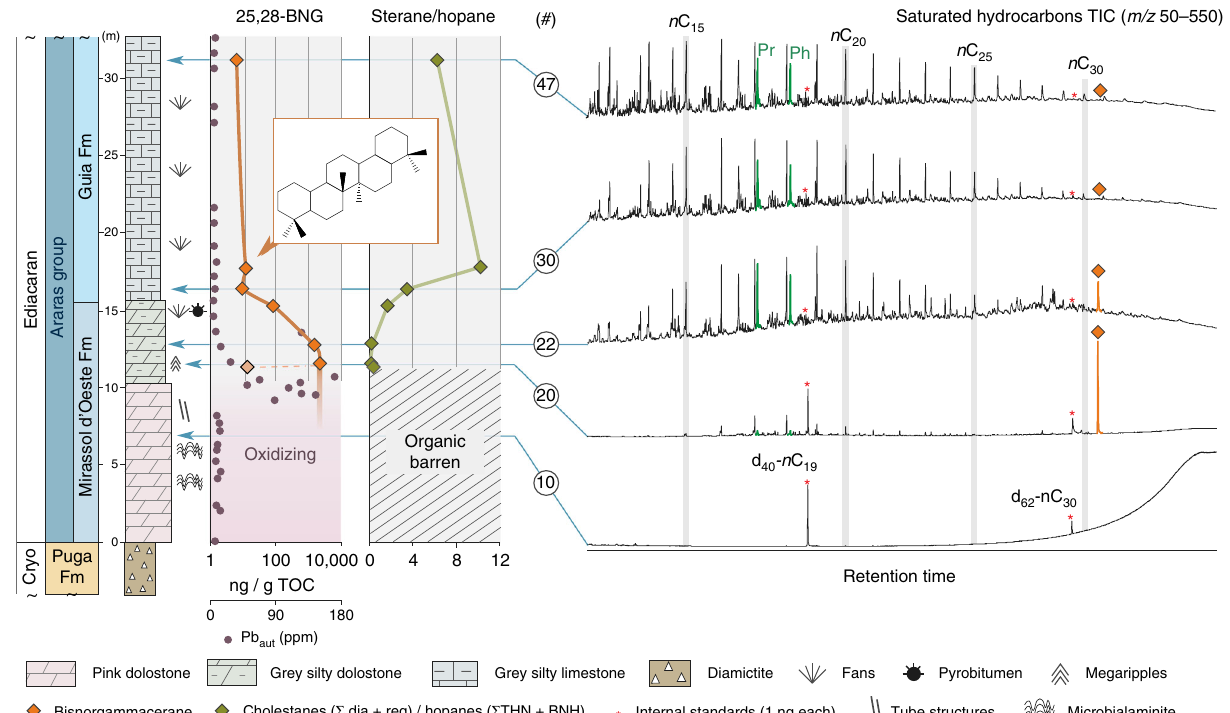
Fig. 1 25,28-bisnorgammacerane in the Araras cap dolostone. The lower Araras cap dolostones contain no preserved hydrocarbons (chromatogram #10), in agreement with an oxidising depositional environment. Following the precipitation and drawdown of redox-sensitive lead (Pb authigenic ) upon decreasing Eh, and allowing for organic preservation (around 11 m), the fi rst observed dominant hydrocarbon biomarker (>1000 ng/g TOC, #20) after the Marinoan Snowball Earth has been identi fi ed as 25,28-bisnorgammacerane (BNG; orange peak). BNG decreases to values < 10 ng/g TOC (note the logarithmic scale) in the overlaying Guia Fm., coincident with the dolostone – limestone transition and parallelled by an increase of phototrophic (pristane and phytane peaks in green)-derived hydrocarbons and a strong increase of eukaryotic over bacterial biomarkers (cholestane ( ∑ dia + reg)/hopanes ( ∑ Ts + Tm + BNH); note that regular 17 α ,21 β (H)-hopanes were not detected in the Araras Group) both indicating an ecological change from a predominantly bacterial community to a phototrophic eukaryotic dominated